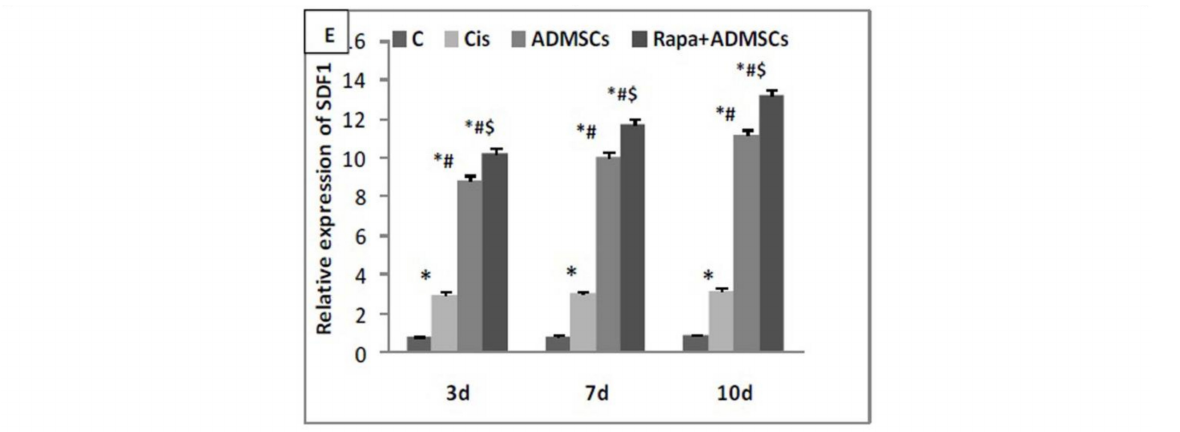
Figure 3. The impact of Rapa-ADMSC administration on ( A ) TGF- β 1, ( B ) IL-6, ( C ) NF-kB, ( D ) HIF-1 α and ( E ) SDF-1 α expression at 3, 7 and 10 days after cisplatin injection. * Significant vs. control, # significant vs. Cis group and $ significant vs. ADMSC